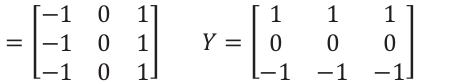
matrix corresponds to a separate pixel. A numerical value is assigned to the corresponding colour, which is then found in this matrix instead of the colour. The filter matrix is a 3x3 square matrix characteristic for a given direction called the transformation kernel (mask). The masks for the horizontal (marked as X) and vertical (marked as Y) directions are different and have the form presented in formula (13).